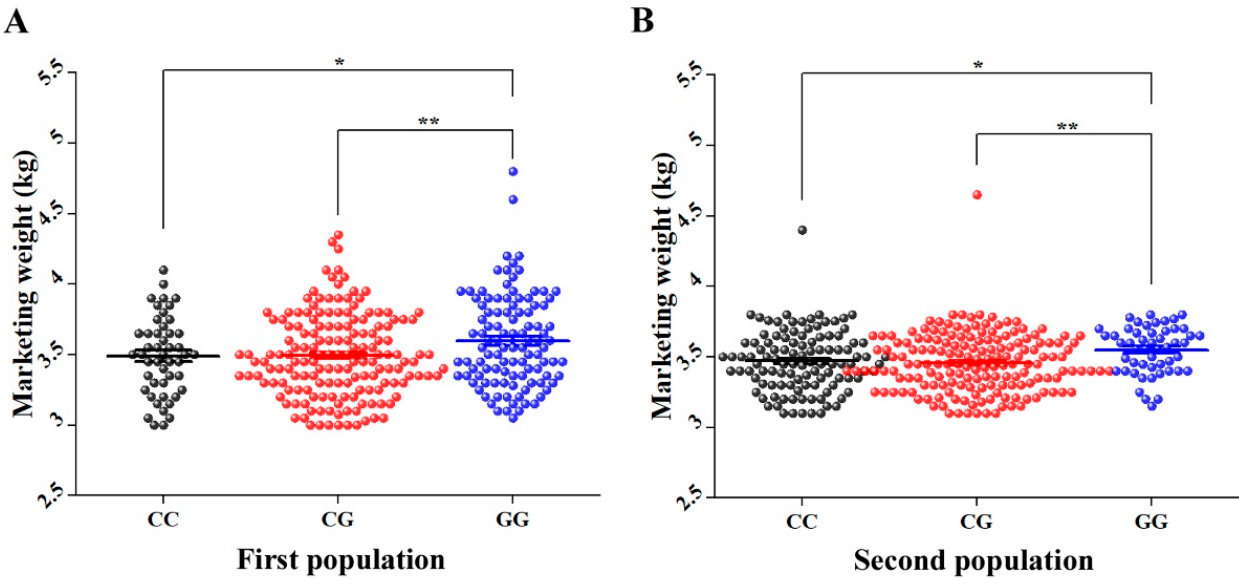
Figure 6. Average MW (kg) of each genotype of SNP Record_1056 in females of ( A ) first population and ( B ) second population. The X axis represents different genotypes groups of Record_1056 in females of P1 and P2. The Y axis represents MW (kg). The error bars represent the standard error of mean. * p < 0.05 and ** p < 0.01.